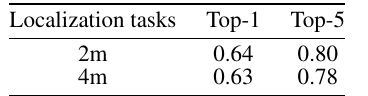
Table 3. Batch size study for 4m localization task with resolution of 50cm and patch dimension of 1024 m 2 . Larger batch size results in better performance.